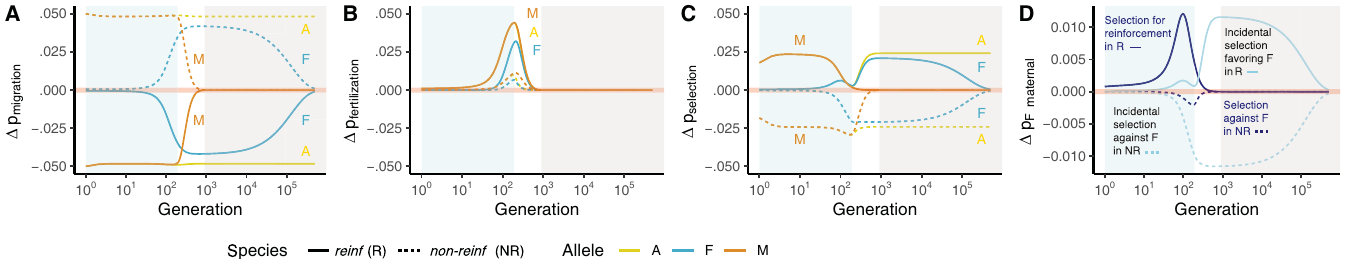
Fig 3. Allele frequency change across the life cycle. The change in frequency of alleles initially unique to reinf ( A , M , and F ) across the metapopulation. The transparent thick pink line at 0 denotes no change in allele frequency during this life phase. ( A ) During migration, alleles decrease in frequency in reinf (solid line, indicated by values below the 0 line) and increase in non-reinf (dotted line, indicated by values above the 0 line). ( B ) During fertilization, alleles native to reinf ( A , M , and F ) increase in both populations. This effect is strongest in the environment of reinf , due to a direct fertilization advantage of M and the benefit to alleles in LD with M . ( C ) Selection in reinf and non-reinf consistently acts to increase and decrease the frequency of A , respectively. Linkage between A and M results in overlapping lines during Phase 1. The transition from Phase 1 to Phase 2 is marked by a dip in the frequency of A , caused by near-fixation of F on the A background, as migrant haplotypes from non-reinf are unable to penetrate reinf at F ’s peak frequency. ( D ) Selection on F is decomposed into 2 components of allele frequency change. In dark blue, we show “selection for reinforcement” (the F allele frequency change attributable to preferential fusion with M ), which enables avoidance of the maladapted a allele in reinf . In light blue, we show the allele frequency change attributable to the incidental gametic phase linkage between F and A ; see Materials and methods for more detail. Parameter values : One local adaptation locus with Selection: s reinf = s non-reinf = 0.75; Migration: g non-reinf ! reinf = g reinf ! non-reinf = 0.1; Recombination: r ¼ r ¼ 0 : 0001 ; Initial allele frequencies: AM MF f M 0,reinf = 1, f M 0,non-reinf = 0, f F 0,reinf = 0.01, f F 0,non-reinf = 0. Background shading marks Phase 1 (light blue), Phase 2 (white), and Phase 3 (grey) of transient reinforcement, as in Fig 2. The data underlying this figure can be found in